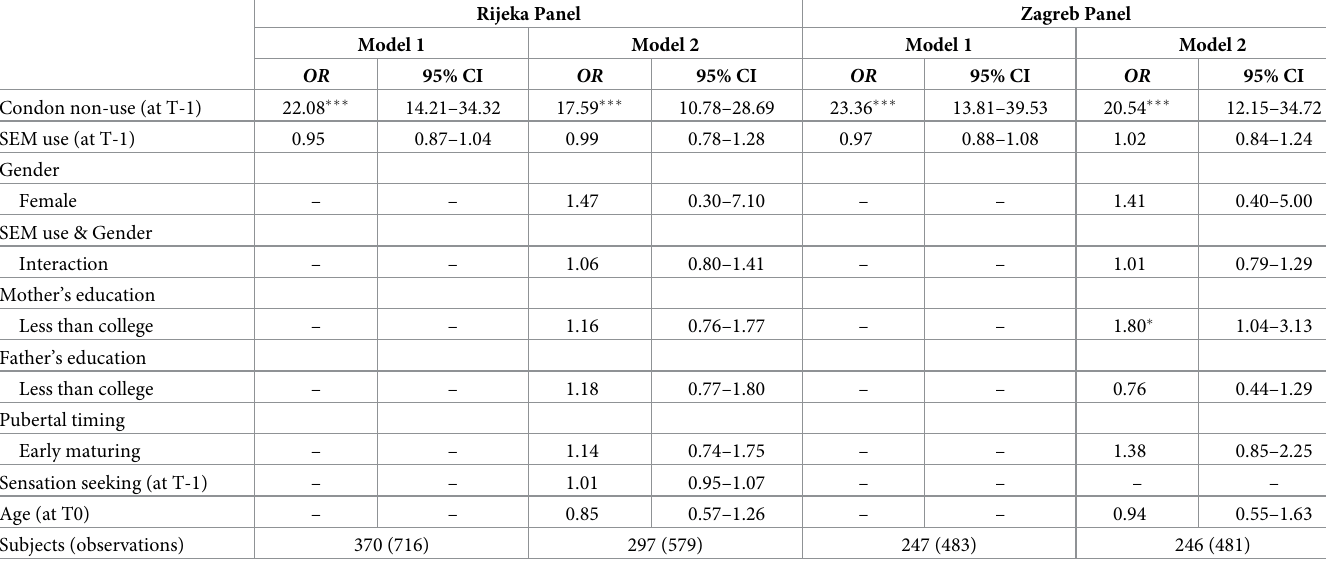
Table 5. Multivariate assessment of the association between the frequency of SEM use and unprotected sexual intercourse in the Rijeka and Zagreb